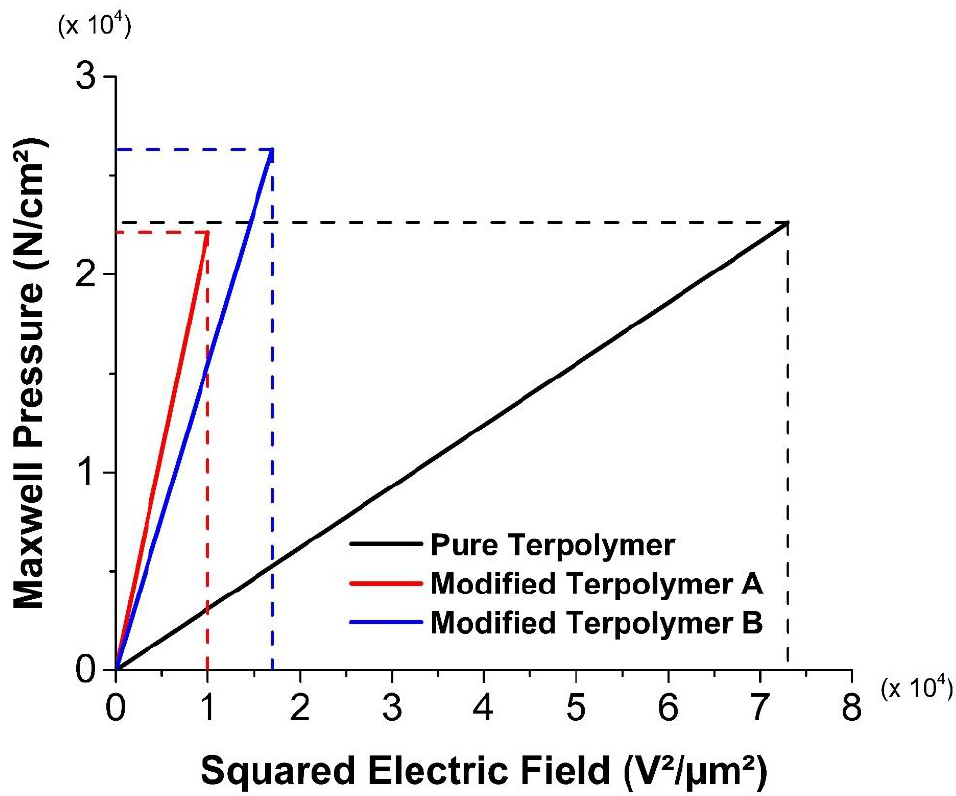
Figure 2. Maxwell pressure versus squared electric field for different electrostrictive materials. Focus on electric breakdown.